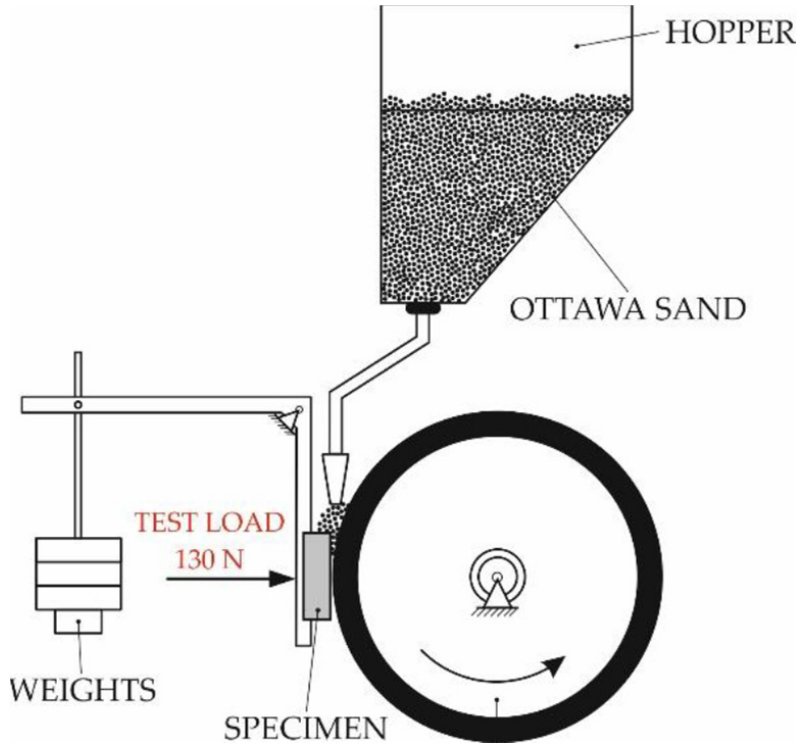
Figure 4. Abrasive wear resistance testing schematic diagram showing the abrasive quartz sand particles sandwiched between the rotating rubber-lined wheel and the stationary surface of the MMC hard-faced layer. Table 3. Abrasive wear resistance testing